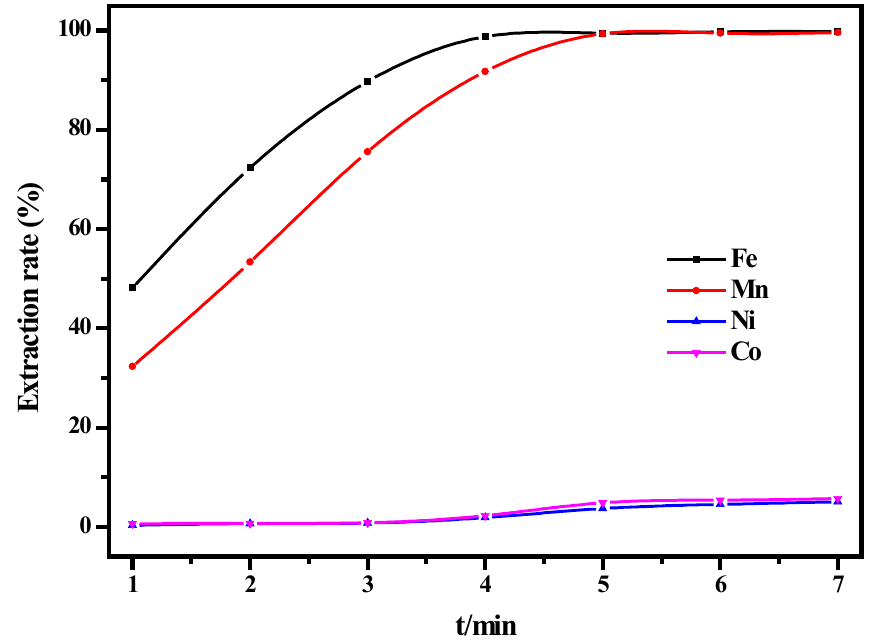
Figure 9. Effect of mixed extraction time on the extraction efficiency of Fe and Mn.